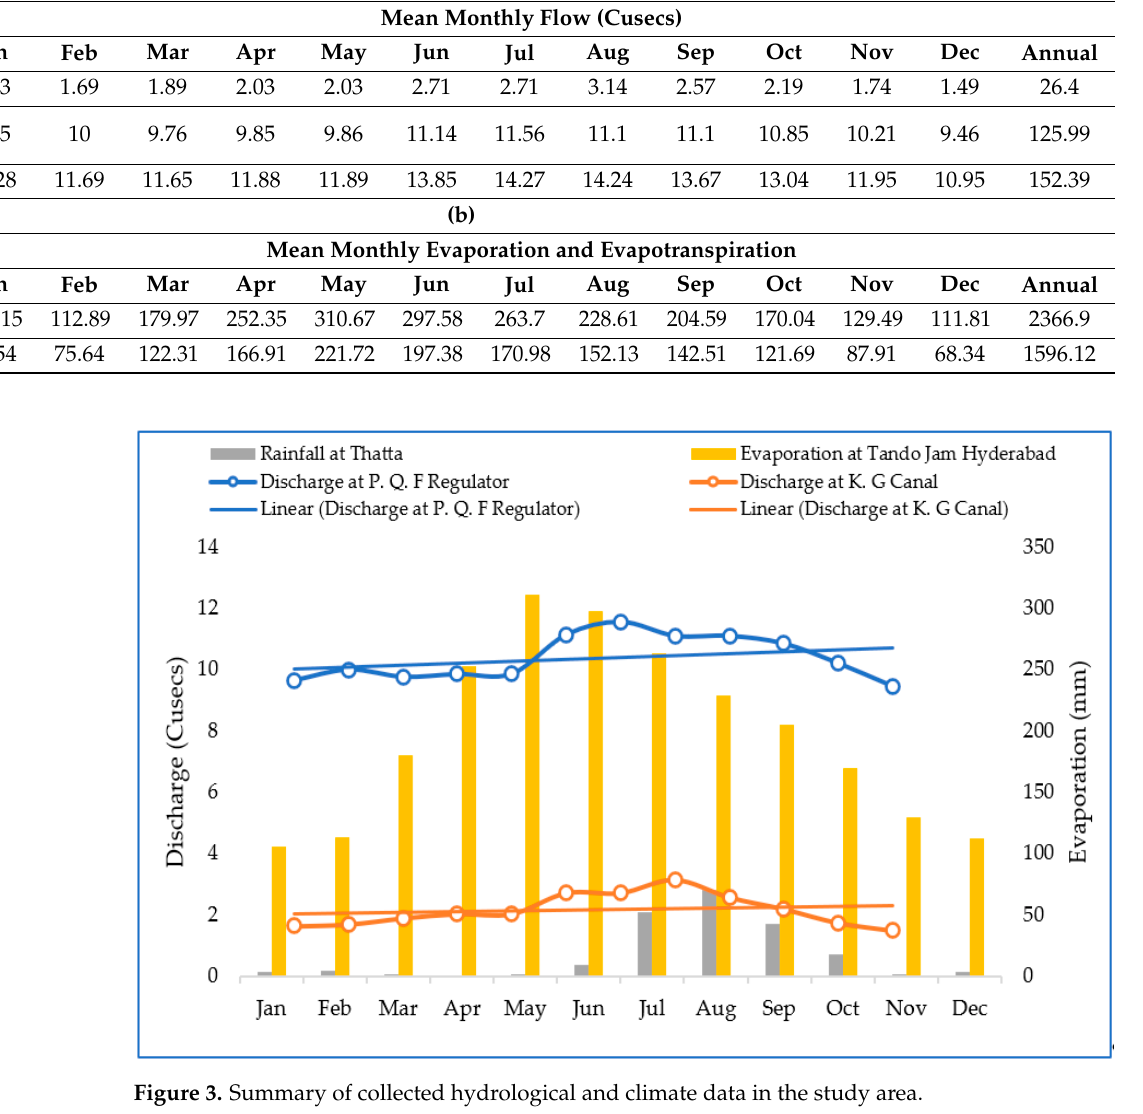
Figure 3. Summary of collected hydrological and climate data in the study area.